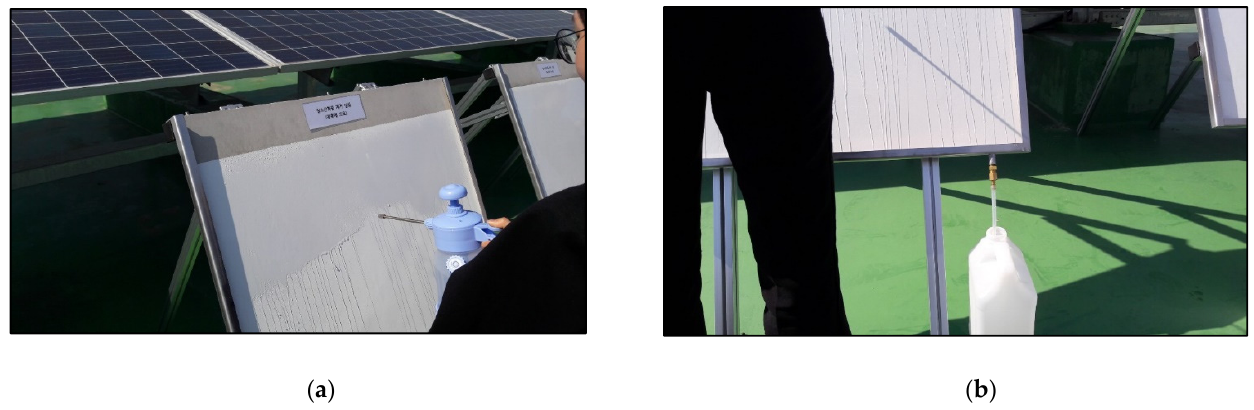
Figure 10. Spraying and collecting process of distilled water. ( a ) Spraying on the CRC panel; ( b ) collecting process of washing water.